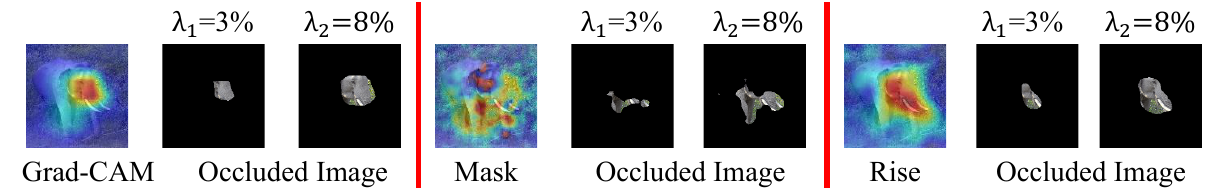
Figure 7. Three visual interpretation algorithms retain 3 % and 8% feature occlusion maps.